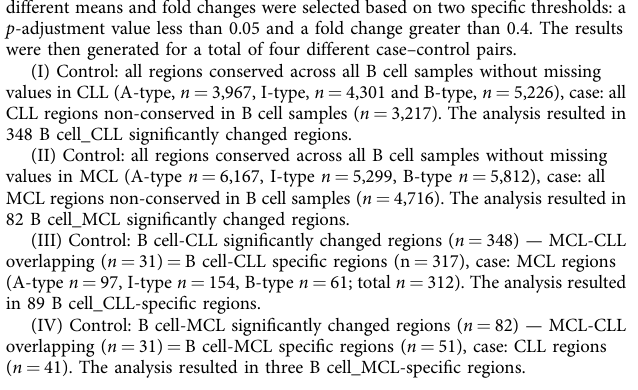
the de fi ned 11 chromatin states using foverlaps function from data.table R package version 1.13.0. The frequency of each chromatin state (corrected by the total fre- quency in the genome) was computed per each genomic compartment. The chromatin state score is thus the median frequency of the three replicas scaled by the columns and the rows using scale function from base R package version